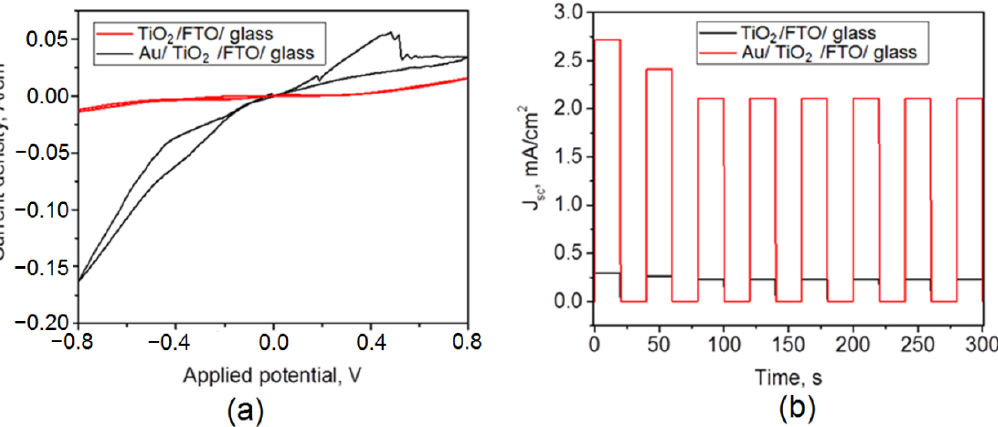
Figure 5. Cyclic voltammogram of the TiO 2 /FTO and Au/TiO 2 /FTO samples ( a ); time variation of the short-circuit current density of the TiO 2 /FTO and Au/TiO 2 /FTO samples ( b ).